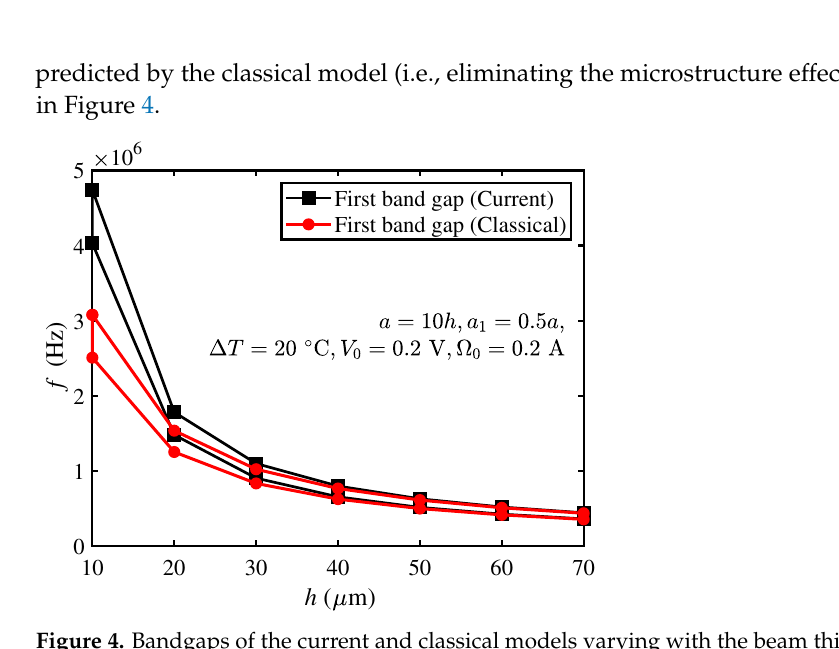
Figure 4. Bandgaps of the current and classical models varying with the beam thickness h .